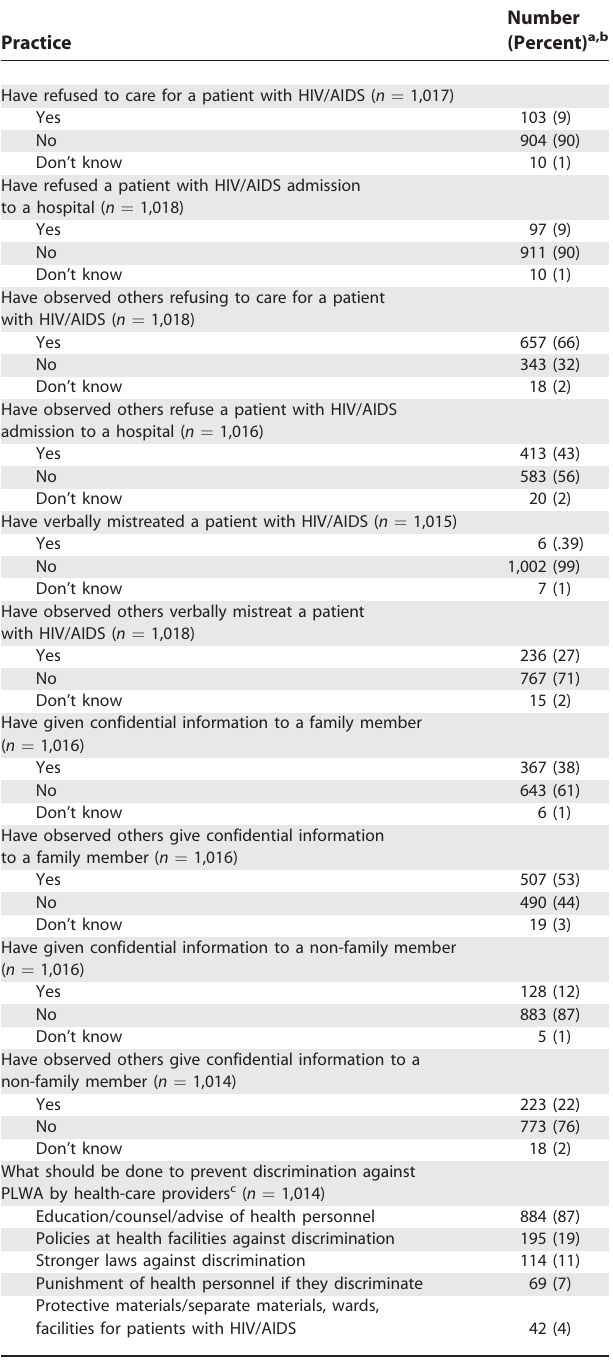
Table 5. HIV/AIDS Treatment and Care Practices Treatment and Care